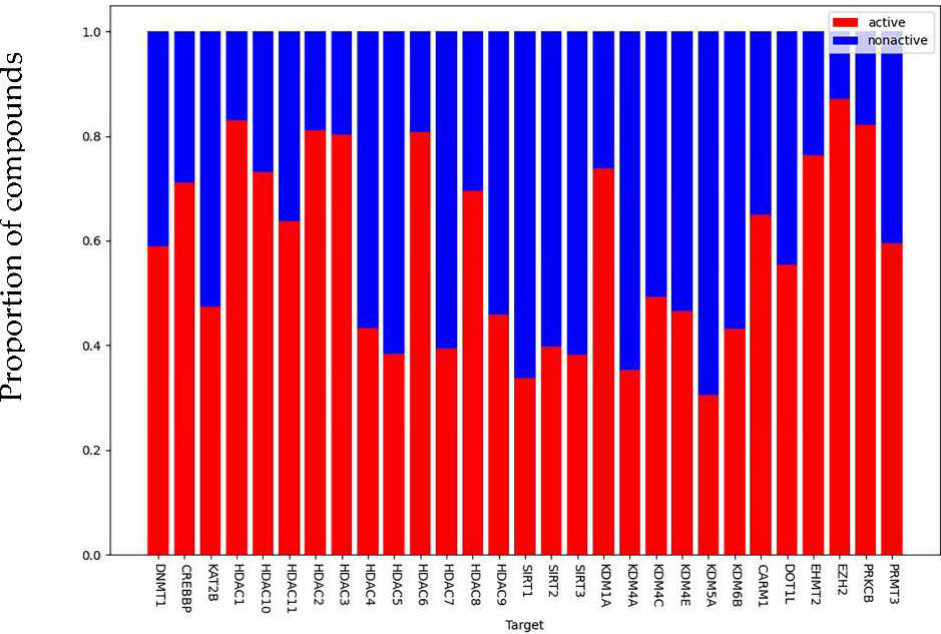
Figure 3. Composition of the target-associated compound data sets. Epigenetic target-associated compound datasets consisted of 693 compounds on average, all 24 compound datasets had different class imbalance levels, showing an average proportion of active compounds of 61.3%, with a maximum of 91.4% of EZH2.